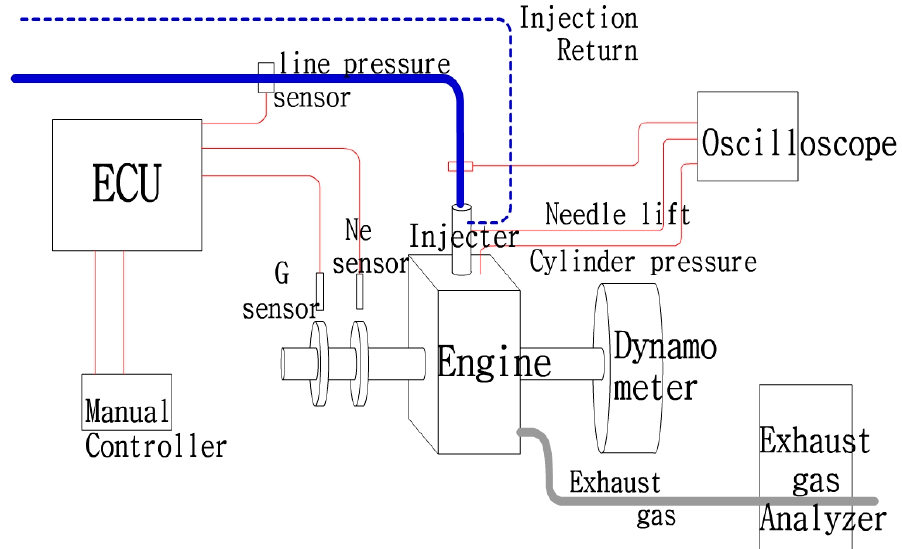
Figure 2. Schematic diagram of the fuel injection control system.